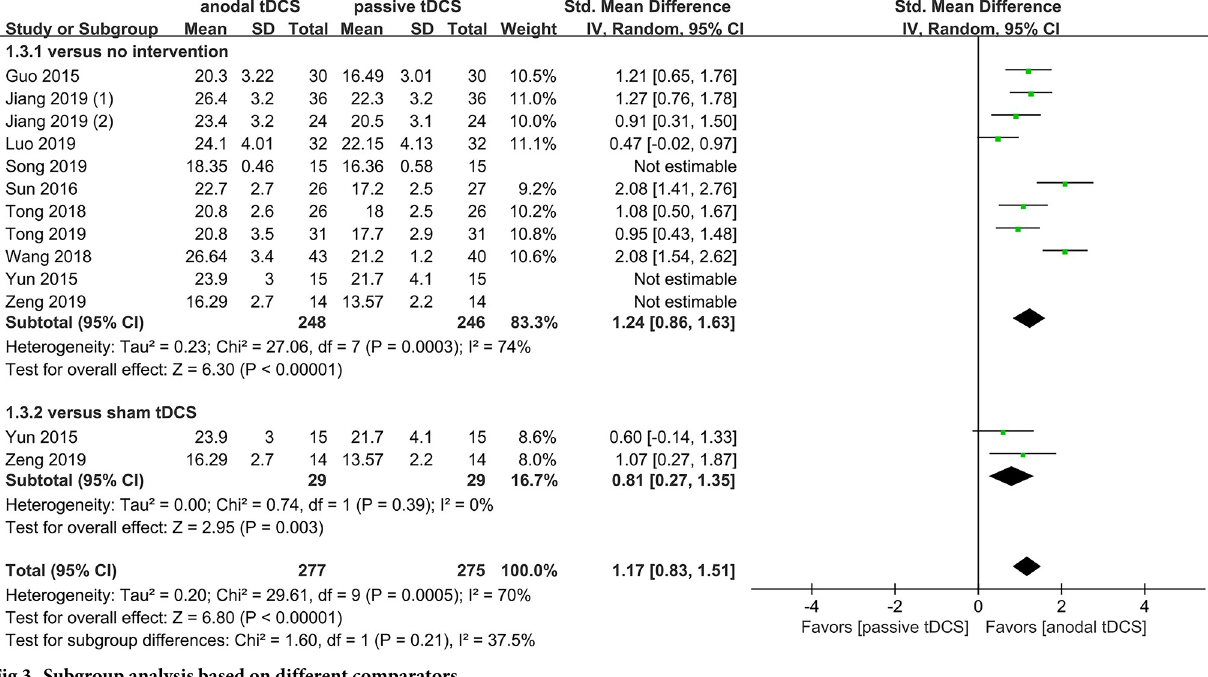
PLOS ONE | https://doi.org/10.1371/journal.pone.0233903 June 9,